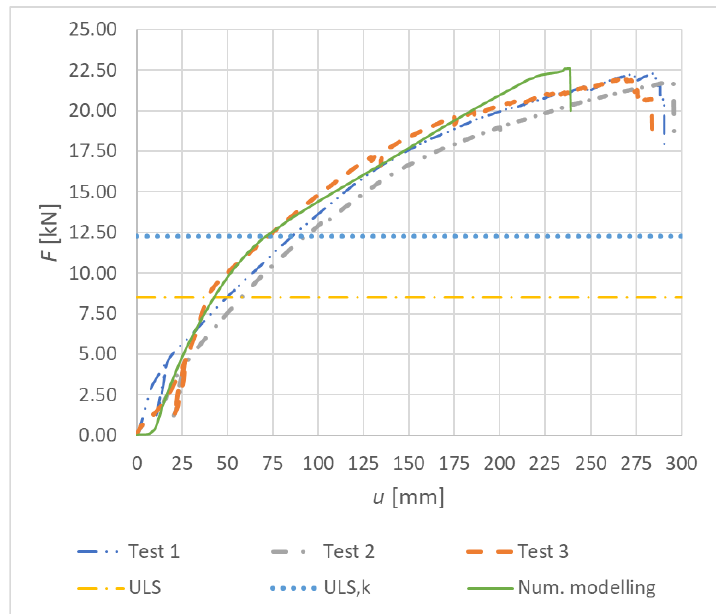
Figure 32. Experiment B: Collapse of the connection during experimental testing (on the ( left )), tensile stress perpendicular to the grain from the numerical model (MPa) (on the ( right )).